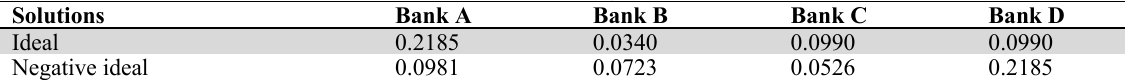
Distances of each bank solution from the ideal and negative solutions